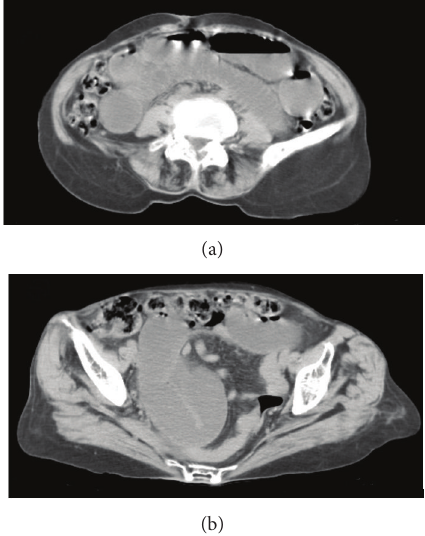
Figure 2: Plain CT scan of lower abdomen and pelvis showing dilated small bowel loops in abdomen and pelvis.